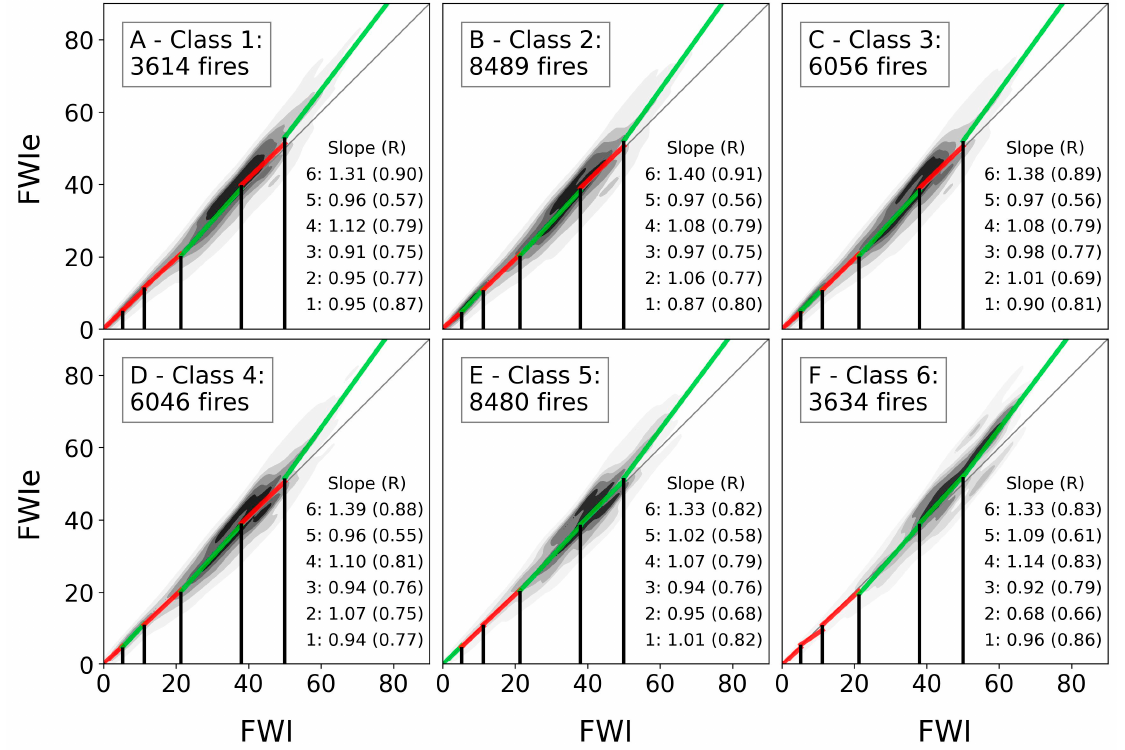
Figure 5. Long-term trends for ( A ) CHI, ( B ) FWI, and ( C ) FWIe, considering only summer months (June to September) for the 1980–2020 period. Computed from a monotonic seasonal Mann–Kendall trend test. Grey shaded areas show pixels where trends were not significant at the 5% statistical level. Trends are shown as the average index change per decade.